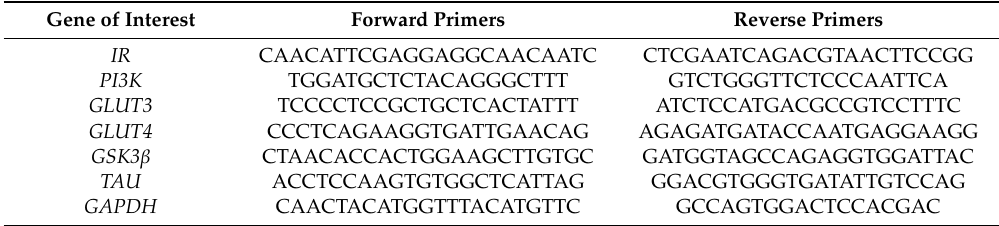
Table 1. Primers for the genes of